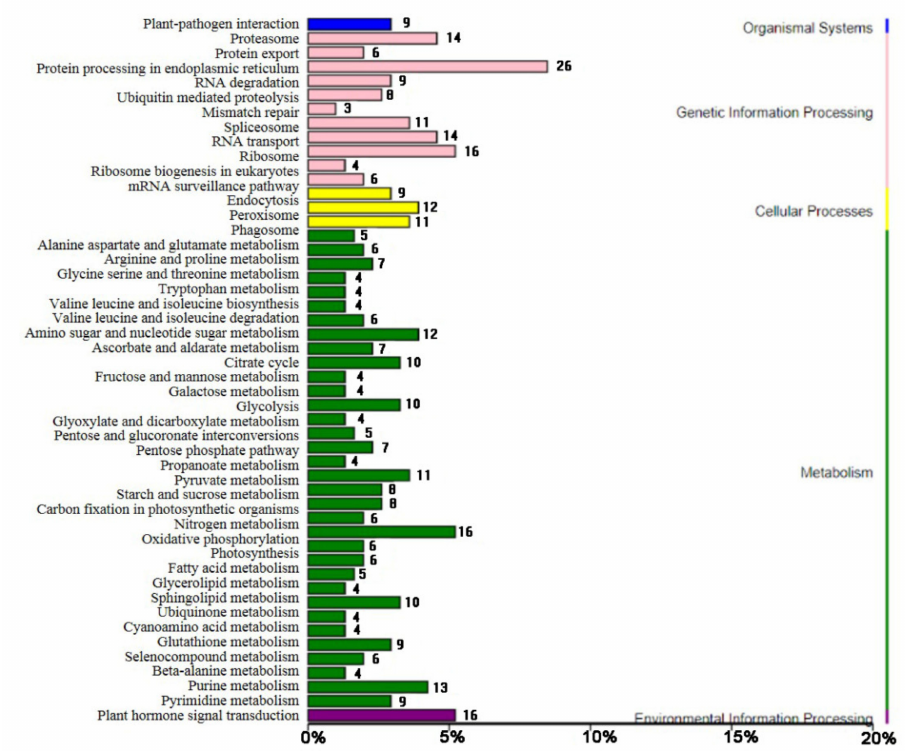
Figure 6. Kyoto Encyclopedia of Genes and Genomes (KEGG) enrichment analysis of differentially expressed genes